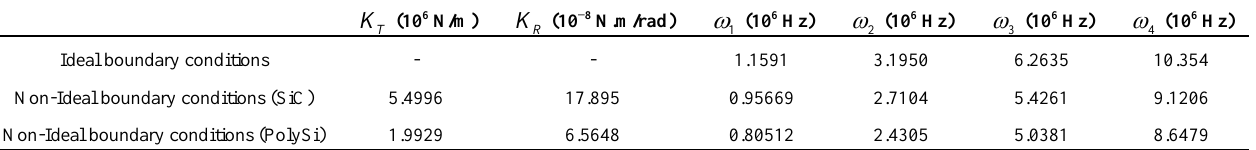
Table 3. The equivalent tangential stiffness and equivalent rotational stiffness of the flexible supports and the first four natural frequencies of the beam. The second and third rows relate to the supports material [51] of silicon carbide (E = 415 GPa, density = 3,200 Kg/m 3 , v = 0.192) and polysilicon (E = 150 GPa, density = 2,300 Kg/m 3 , v = 0.226), respectively.